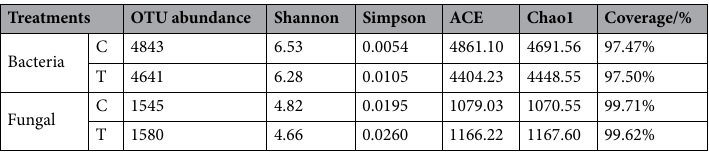
Table 1. Bacterial and fungal Alpha-diversity index of diferent